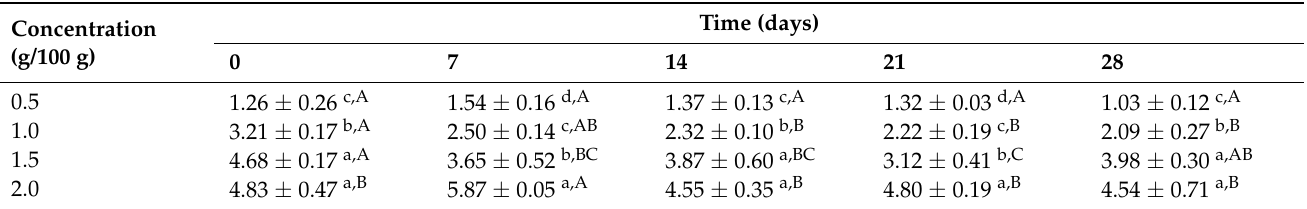
Table 2. Anthocyanin (mg cyanidine-3-glucoside/kg sample) extracted from sweetened plain whole- fat yogurts with addition of jabuticaba skin powdered extract at different concentration levels during refrigerated storage.